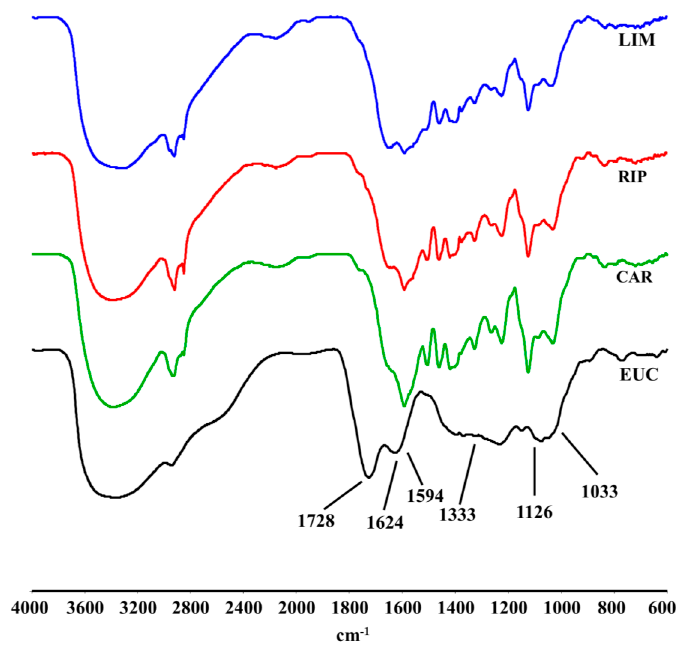
Figure 1. DRIFT-IR spectra of water-soluble lignins isolated from cardoon (CAR), eucalyptus (EUC), black poplar grown in Ripiti (RIP) and black poplar grown in Limatola (LIM) by an alkaline oxidative extractant.